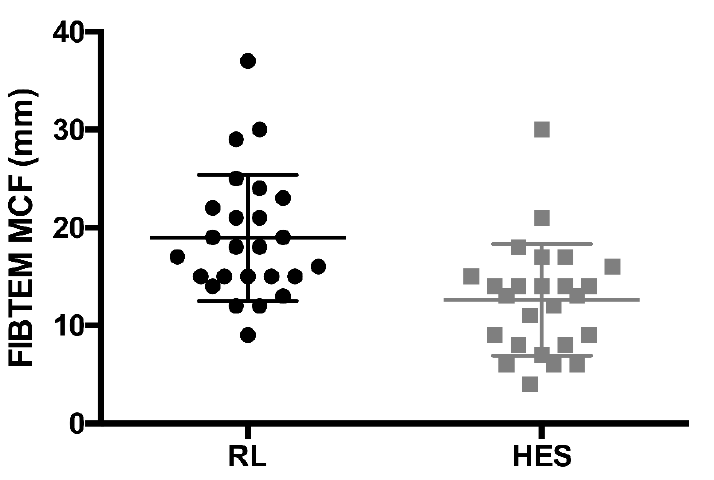
Figure 2. Difference in perioperative minimum of FIBTEM MCF: RL 19 ± 6 mm vs. HES 13 ± 6 mm; p < 0.001 (HES, hydroxyethyl starch; MCF, maximum clot firmness; RL, Ringer’s lactate).